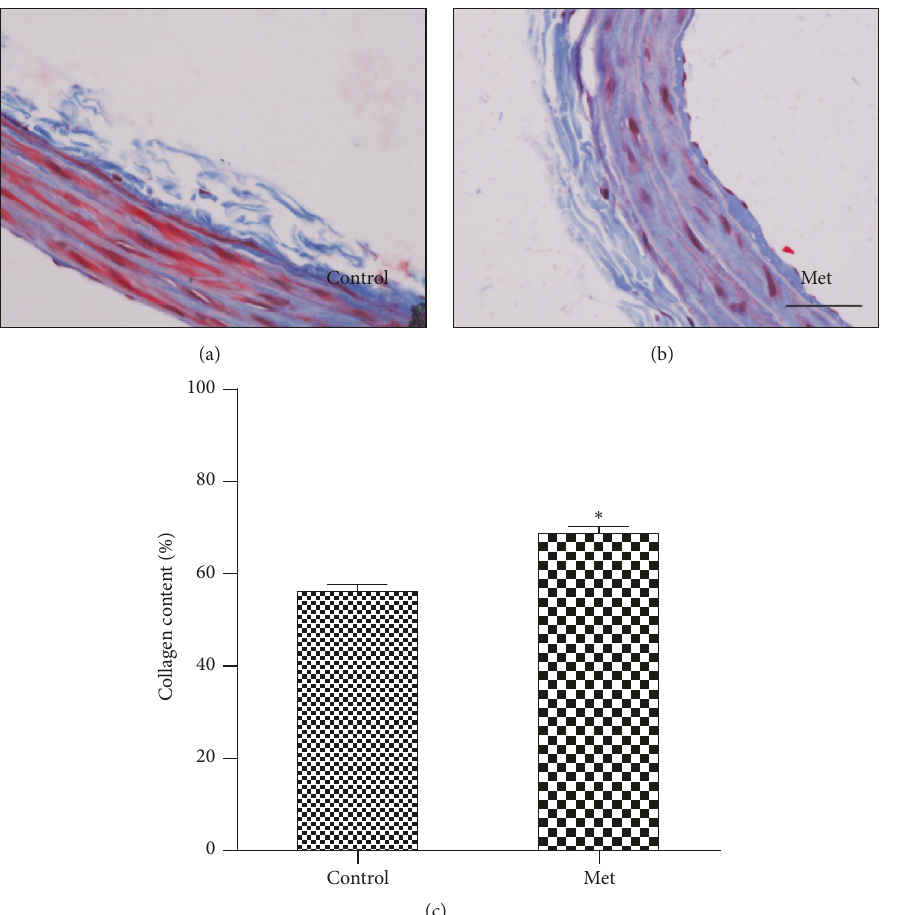
Figure 3: Histological analysis of carotid artery in the control-diet group and the Met-diet group. Tissue sections were labeled with trichrome (blue) for collagen. The staining showed hyperhomocysteinemia induced collagen accumulation in carotid artery in the Met-diet group (b) compared with representative vessels from the control-diet group (a). Collagen content was significantly increased in the Met-diet group ( ∗ 𝑝 < 0.05 ) (c). Original magnification was × 400 for (a)-(b) and the scale bar = 50 um. Values are mean ± SEM.